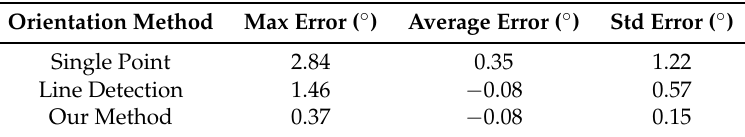
Figure 10. Comparison of three orientation methods. Table 2. Angle estimation errors of three orientation methods.